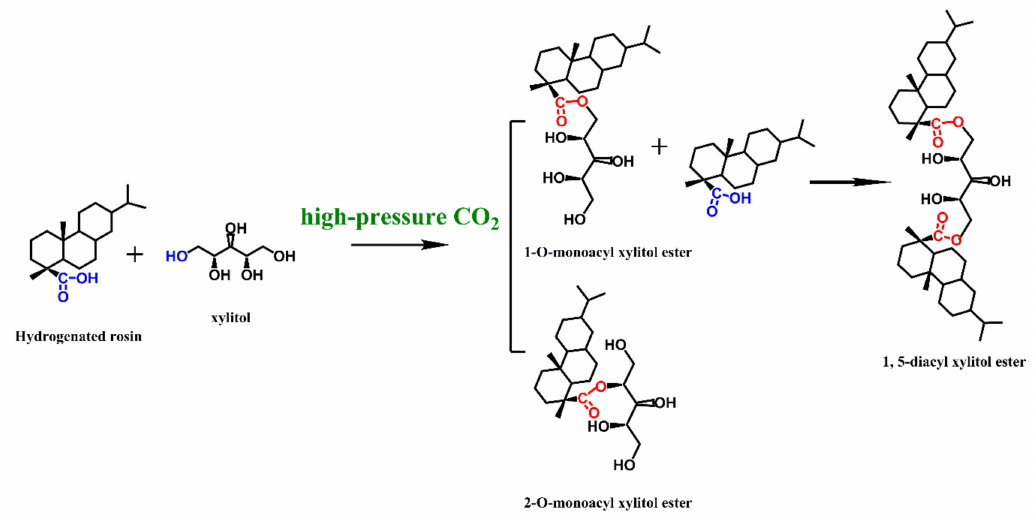
Figure 1. Reaction network diagram of hydrogenated rosin and